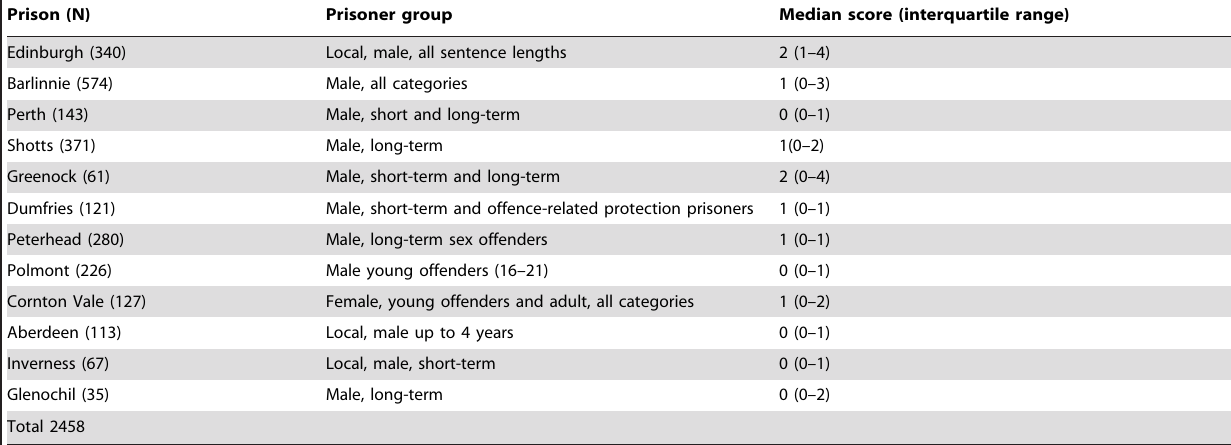
Table 2. Scores on screening tool by prison.